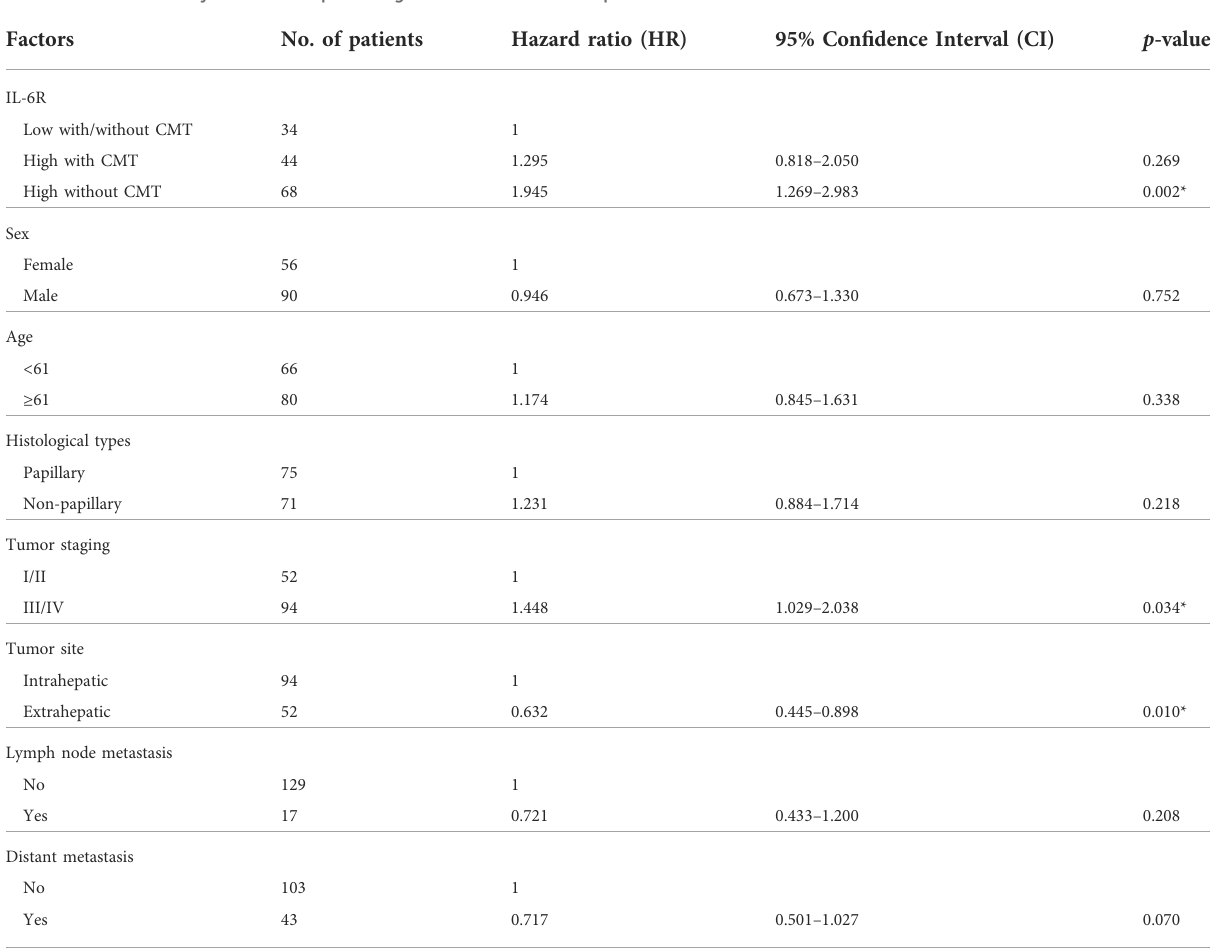
TABLE 1 Univariate analysis of factors predicting overall survival of CCA patients.